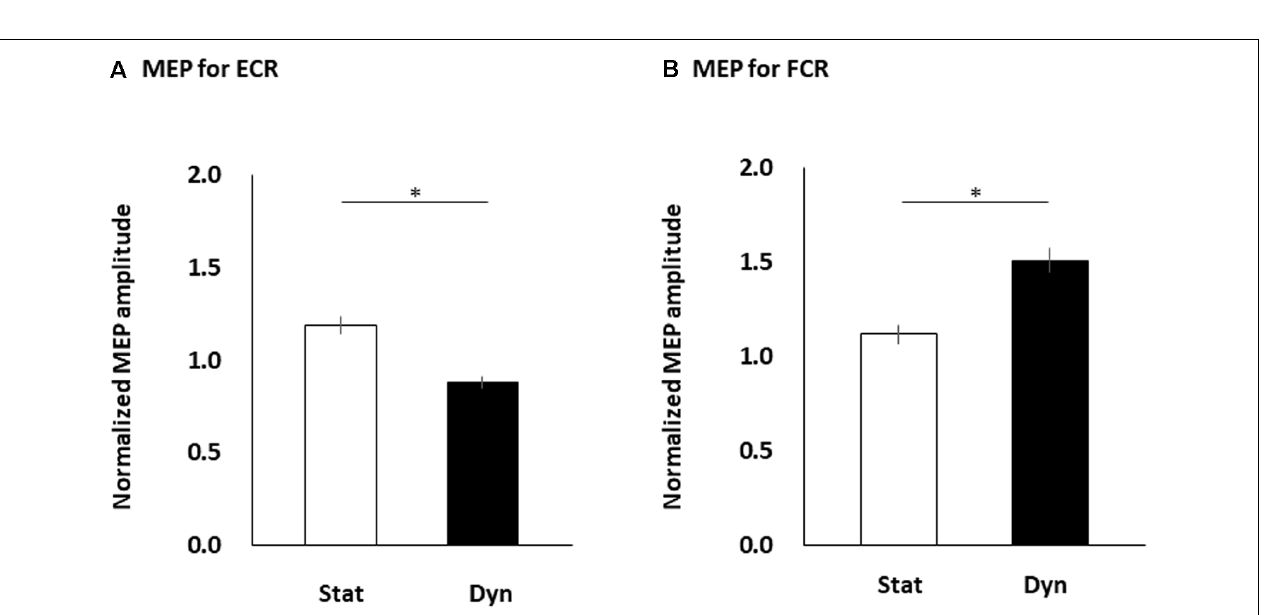
FIGURE 4 | The MEP amplitudes of the ECR (A) and FCR (B) muscles during the static and dynamic conditions. The columns and error bars denote the means and standard errors of the mean, respectively. Normalized MEP amplitude was calculated by that each MEP amplitude in static and dynamic conditions divided by mean MEP amplitude in control condition in each participant’s FCR or ECR. The normalized ECR MEP amplitudes significantly increased in the static condition compared to the dynamic condition ( ∗ p < 0.0001). However, the normalized FCR MEP amplitudes significantly increased in the dynamic condition compared to the static condition ( ∗ p < 0.0001). MEP, motor evoked potential; FCR, flexor carpi radialis; ECR, extensor carpi radialis; Stat, static condition; dyn, dynamic